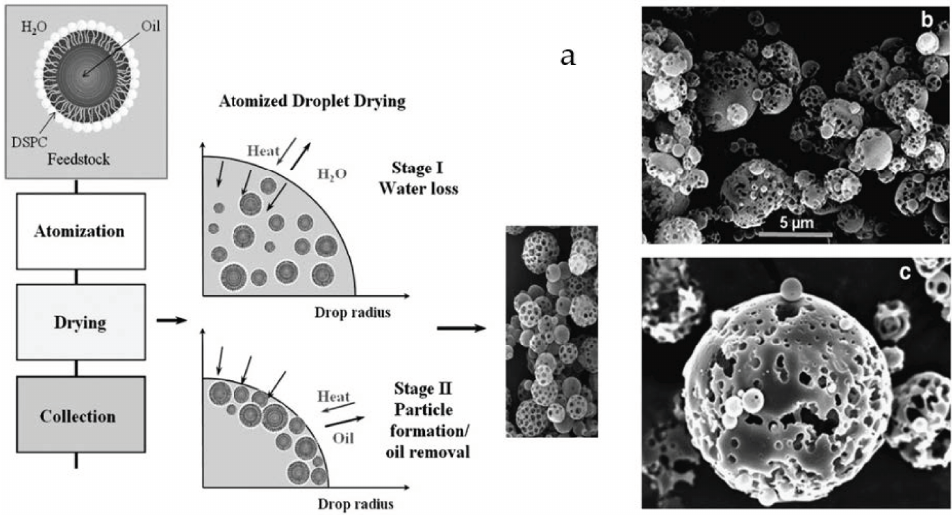
Figure 5. ( a ) Emulsion based spray drying process for manufacturing phospholipid porous particles. Oil-in-water emulsion droplets are created by high-pressure homogenization of perflubron in water. The dispersed oil droplets are stabilized by a monolayer of DSPC. Resulting feedstock is atomized into a hot air stream in a spray dryer. Water is evaporated during the initial stages of the drying process decreasing the particle diameter. Further drying evaporates the perflubron, leaving behind pores in the particle. ( b ) Scanning electron microscope (SEM) images of tobramycin inhalation powder particles and dimensions and ( c ) Tobramycin inhalation powder particle (closeup) [29,87]. Reprinted with permission of Mary Ann Liebert, Inc. Copyright © 2011 Mary Ann Liebert,